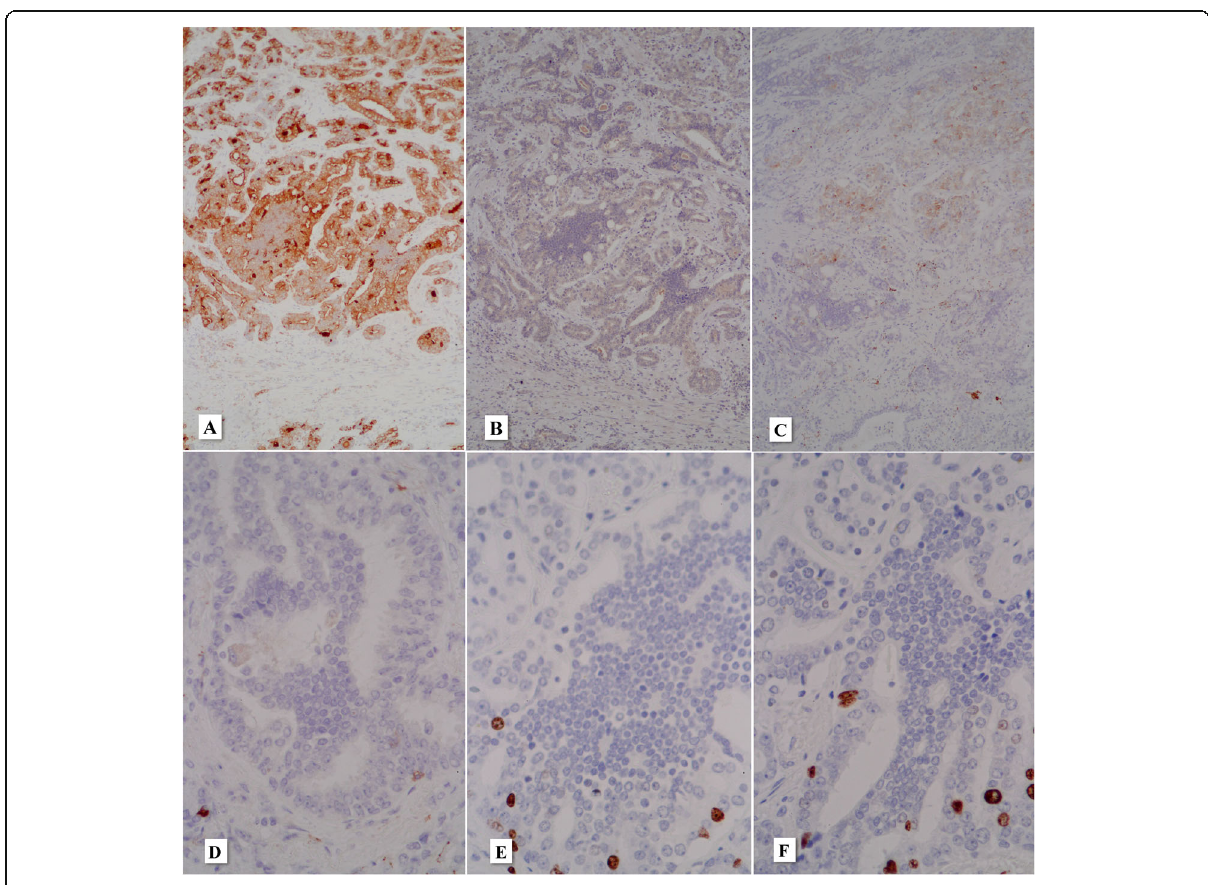
Fig. 6 Immunophenotype of small cell-like change in intraductal carcinoma. Absent expression of PSA ( A : PSA, 100x) and absent expression of chromogranin ( B : chromogranin, 100x). Synaptophysin expression was not observed in small cell-like change in intraductal carcinoma, however, focal expression was observed in usual acinar adenocarcinoma in the vicinity ( C : Synaptophysin, 100x). CD56 expression was not observed in small cell-like change in intraductal carcinoma, however, scattered cells were positive in usual acinar adenocarcinoma in the vicinity ( D : CD56, 400x). Ki67-positive cells are easily seen in the periphery of intraductal carcinoma, but no expression was detected in small cell-like areas ( E and F : Ki67, 400x)